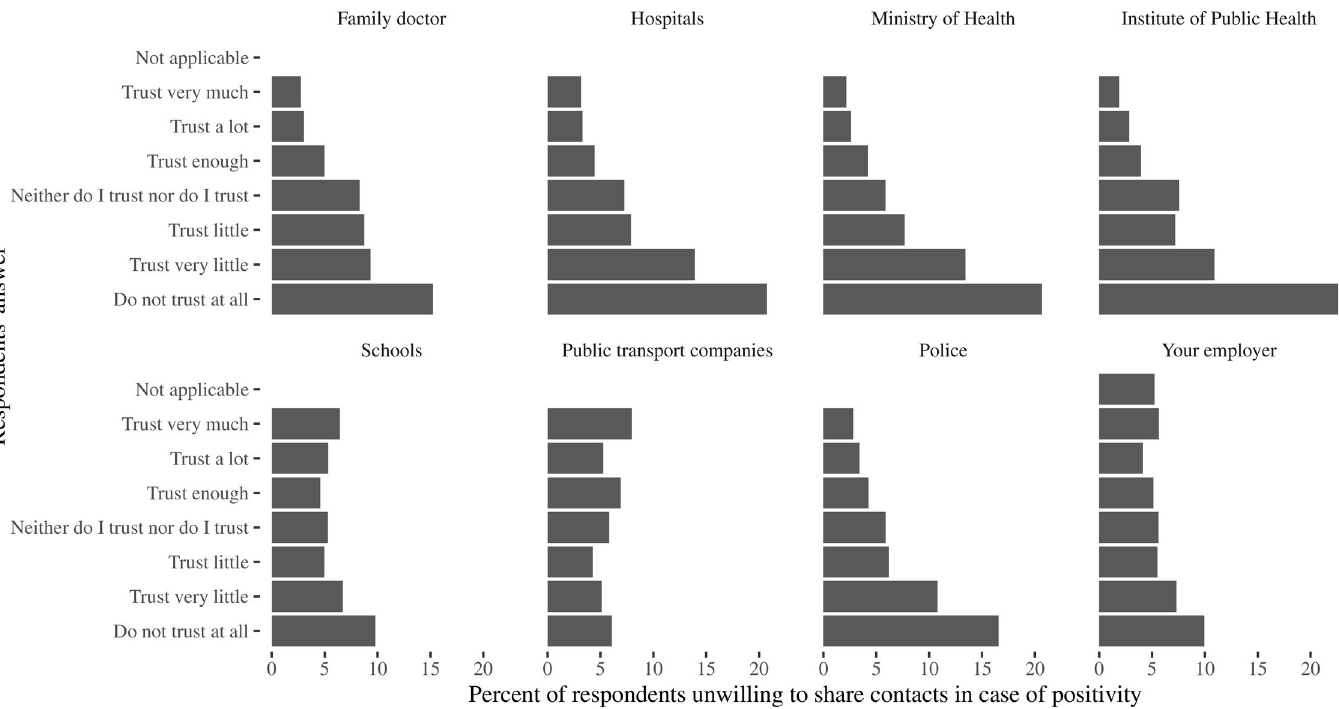
Fig 5. Percent of respondents who expressed unwillingness to share contacts in case of positivity, according to their response to the questions “How much trust you have that the following institutions or persons can effectively manage the COVID-19?”. The institutions are named at each panel on the figure.